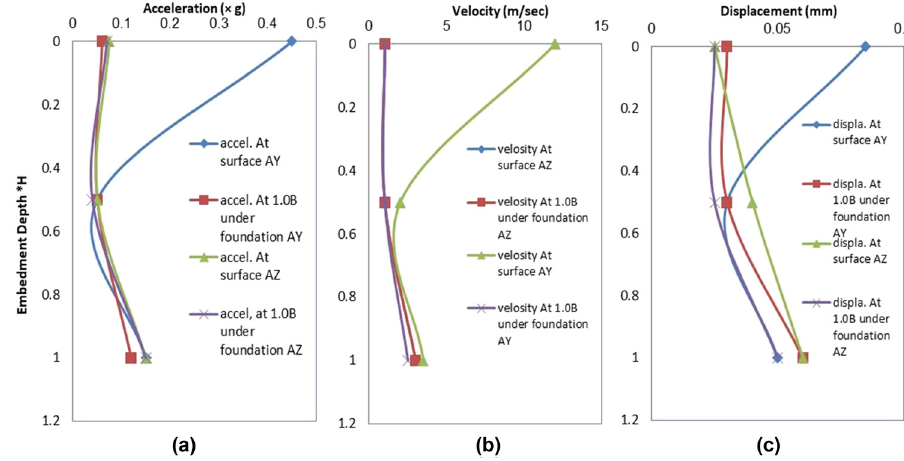
Figure 7: Relationship between embedment depth vs ( a ) acceleration, ( b ) velocity, and ( c ) displacement.